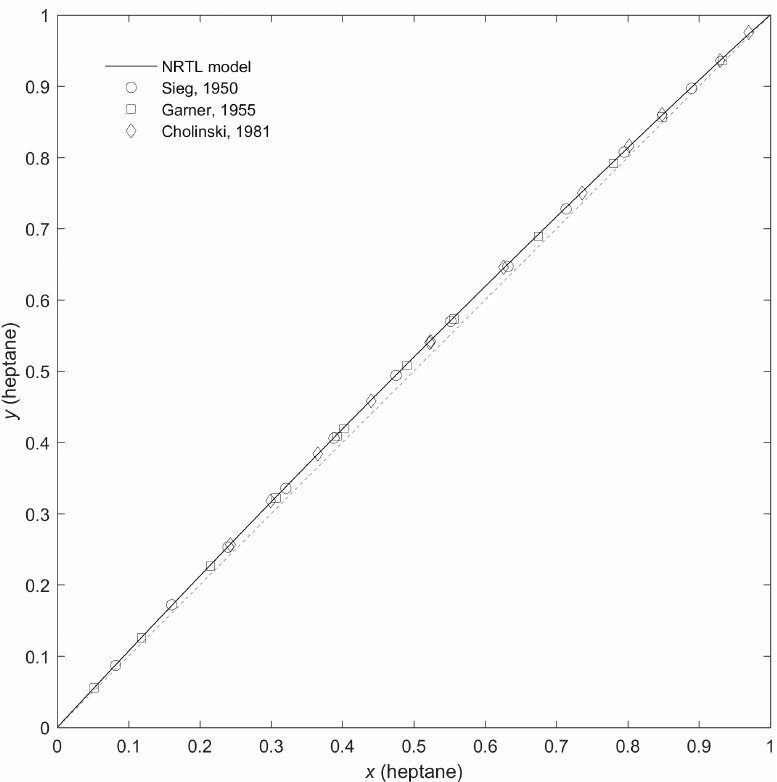
Fig. 1 – VLE data and NRTL model for the heptane–methylcyclohexane sys- tem